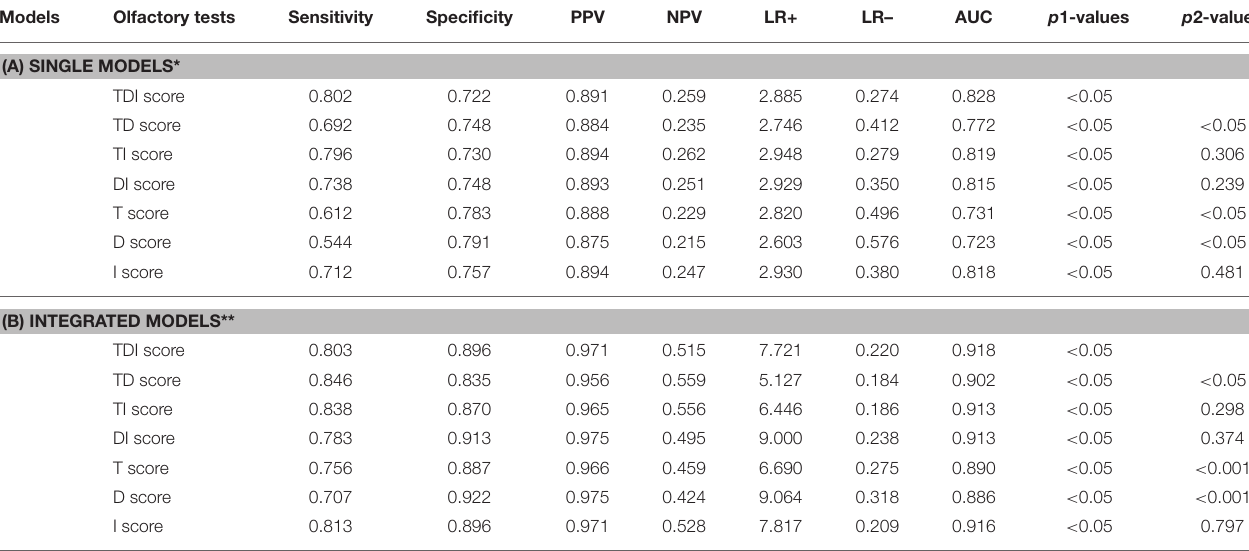
TABLE 3 | Area under the receiver operating characteristic curve (AUC) of different olfactory domains and their sensitivity, specificity, LR + , LR–, PPV, and NPV in single olfactory models and integrated models.